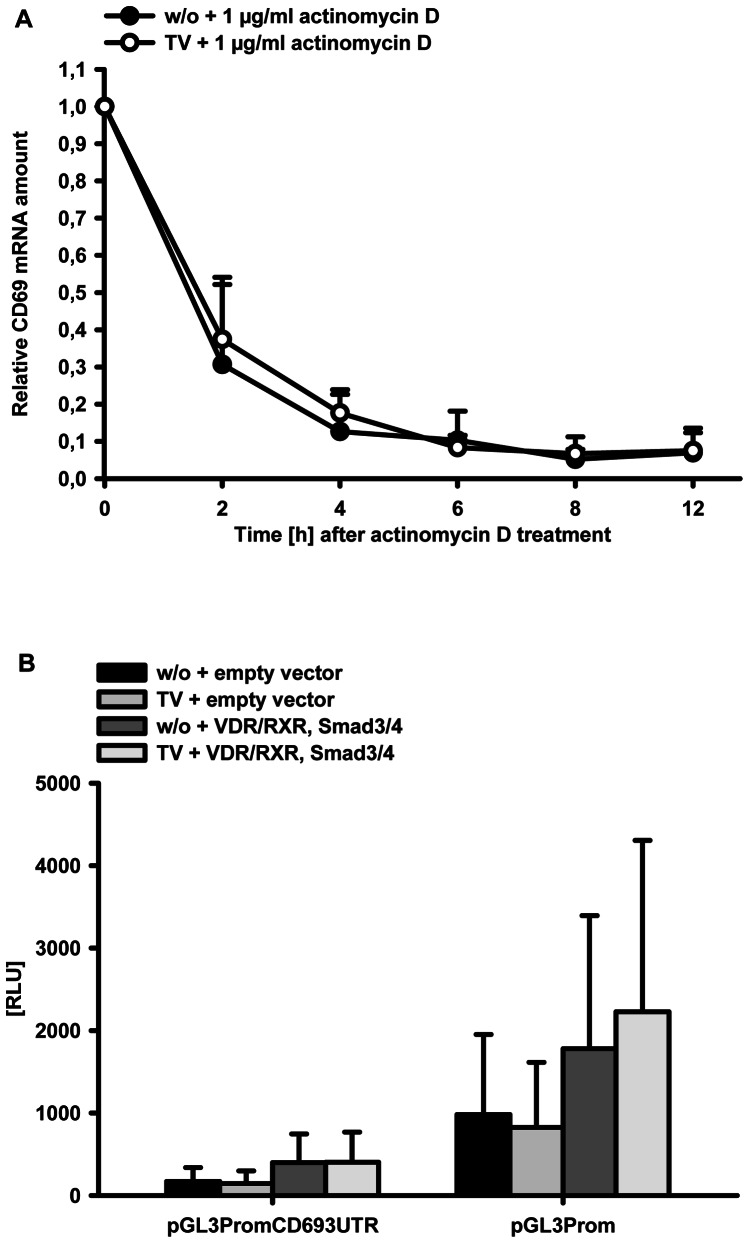
Influence of TGF-β/1α,25(OH)2D3 on CD69 mRNA half life.(A) Cells were treated with 1 ng/ml TGF-β and 50 nM 1α,25(OH)2D3 (TV) for 24 h or left untreated as control (w/o). Then 1 µg/ml actinomycin D was added to both treatment groups and cells were harvested at the indicated time points after actinomycin D treatment. Subsequently, mRNA levels were determined by qPCR. Data are expressed relative to time zero (immediately before addition of actinomycin D) (B) HeLa cells were transfected with the indicated reporter plasmids and expression vectors encoding human vitamin D receptor (VDR), retinoid X receptor (RXR), Smad3 and Smad4 or the corresponding empty vectors. Cells were either treated with 1 ng/ml TGF-β and 50 nM 1α,25(OH)2D3 (TV) or left untreated (w/o). Luciferase activity was measured 24 h after treatment. The data are presented as relative luminescence units (RLU, luciferase activity of reporter plasmid normalized to the luciferase activity of the internal standard plasmid).